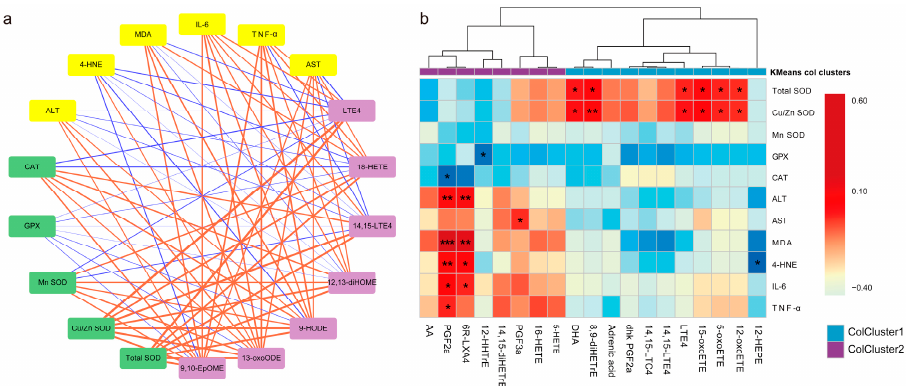
Figure 8. Association analysis of oxylipins and liver phenotypes. ( a ) Correlation network between differential oxylipins and liver biochemical indicators. The red line indicates a positive correlation and the blue line indicates a negative correlation. The thicker lines represent stronger correlations. ( b ) Screen oxylipins with strong phenotype correlation perform hierarchical clustering. “*” means p < 0.05, “**” means p < 0.01, “***” means p < 0.001.